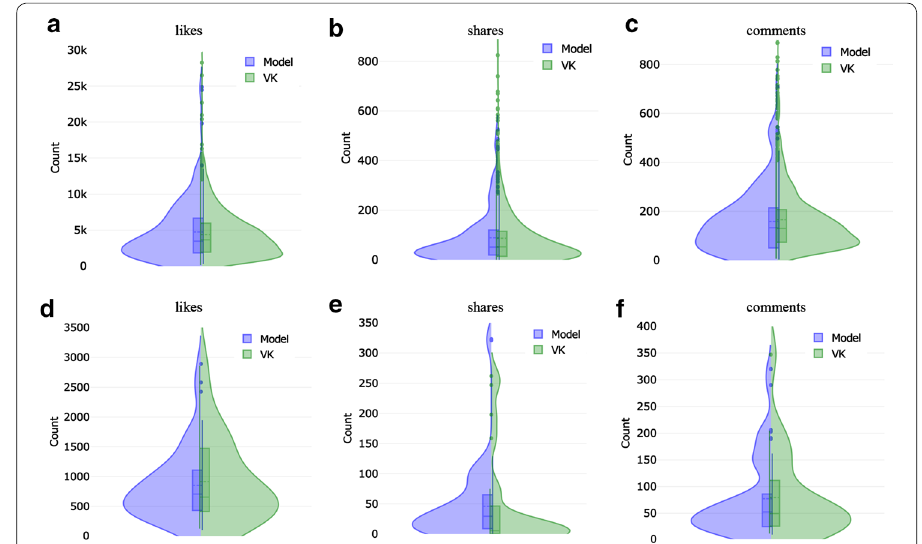
Fig. 10 Comparison of aggregated responses to messages for two types of IMs in news community: a , b , c for regular news; d , e , f for an advertising post